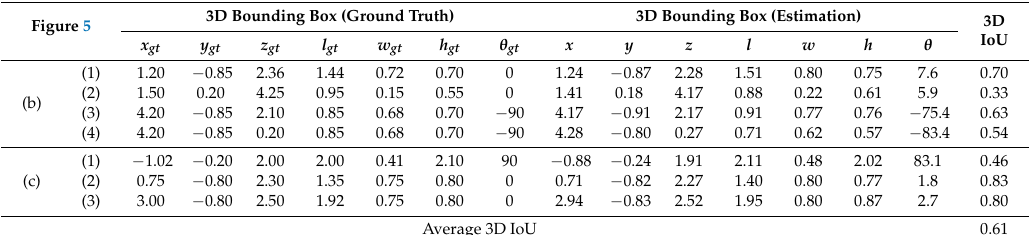
Table 4. Quantitative experiments of 3D object detection in indoor scenes 1 . Figure 5 3D Bounding Box (Ground Truth) 3D Bounding Box (Estimation) 3D